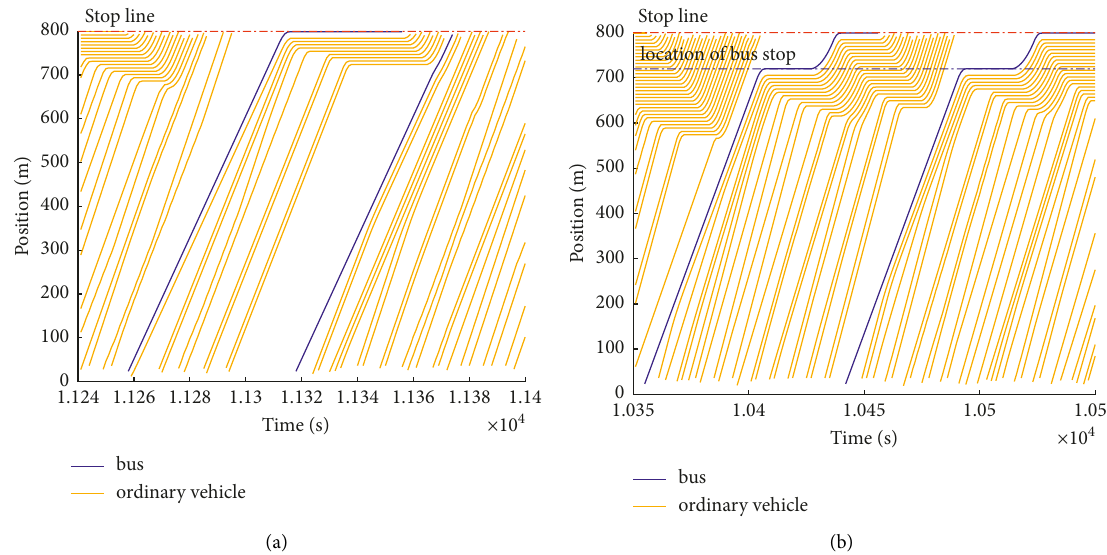
Figure 16: Trajectory of vehicles on the bus lane of IBL-C (partial display). (a) Trajectory of vehicles without near-side stop in the section. (b) Trajectory of vehicles with near-side bus stop in the